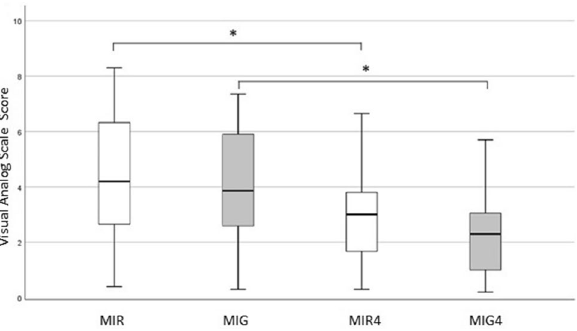
Figure 3. Boxplot representing median values, 25–75% range (box), and min–max range (bars) of vividness expressed by visual analog scale (VAS) score (y-axis) of motor imagery of reaching (MIR) and motor imagery of grasping (MIG) before and after four weeks of training (MIR4, MIG4 respectively). The lower number, the higher the vividness*— P = 0.002 (assessed by Wilcoxon signed-rank test).